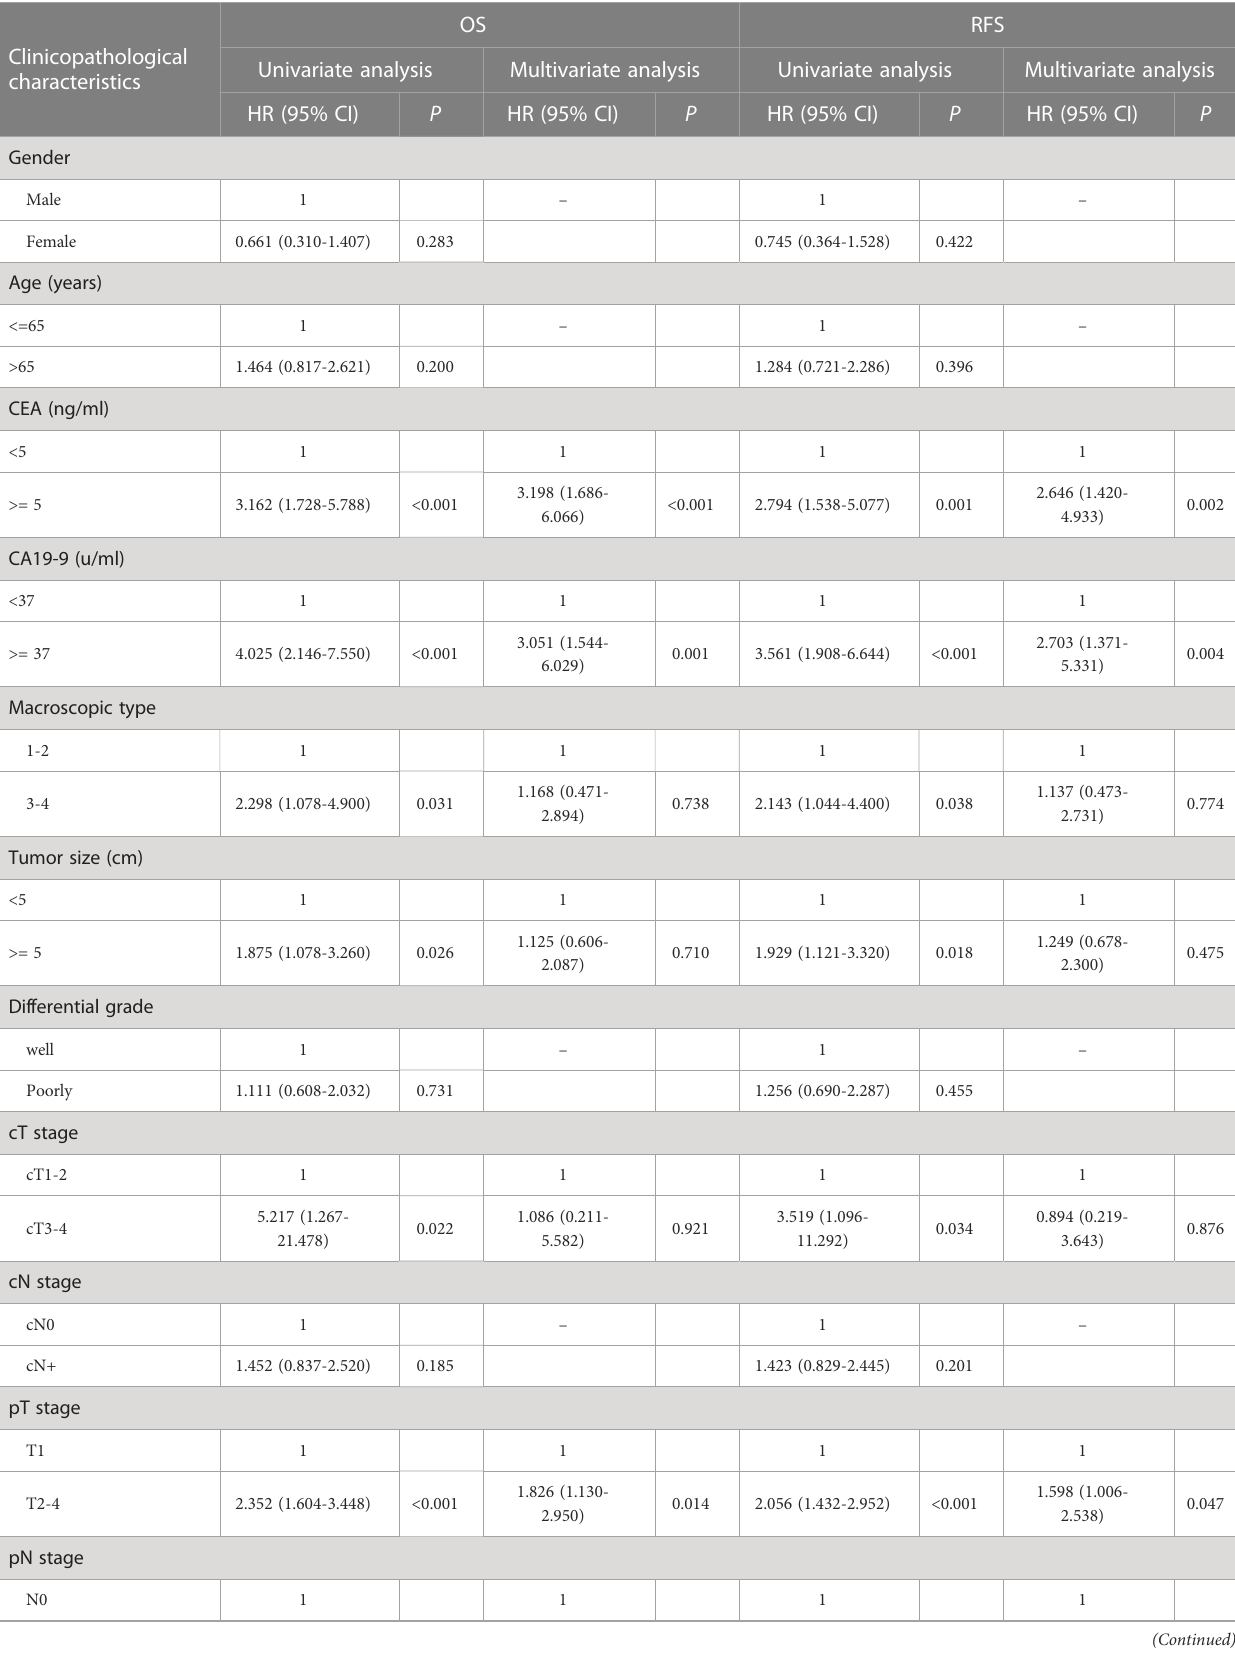
TABLE 4 Univariate and multivariate analysis of risk factors for OS and RFS of patients in the sPAN